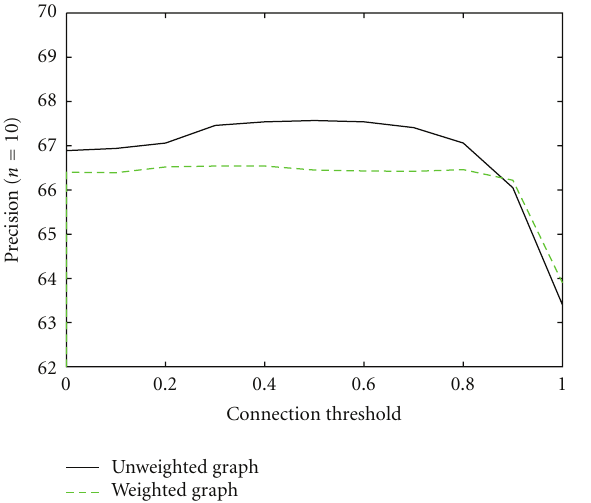
Figure 7: Precision values on Jester according to the connectivity threshold θ .